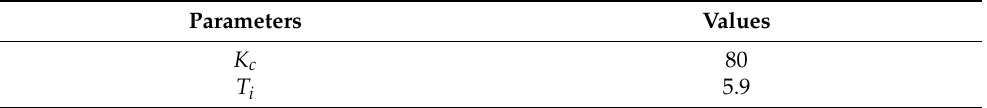
Table 4. PI tuning trial and error values.